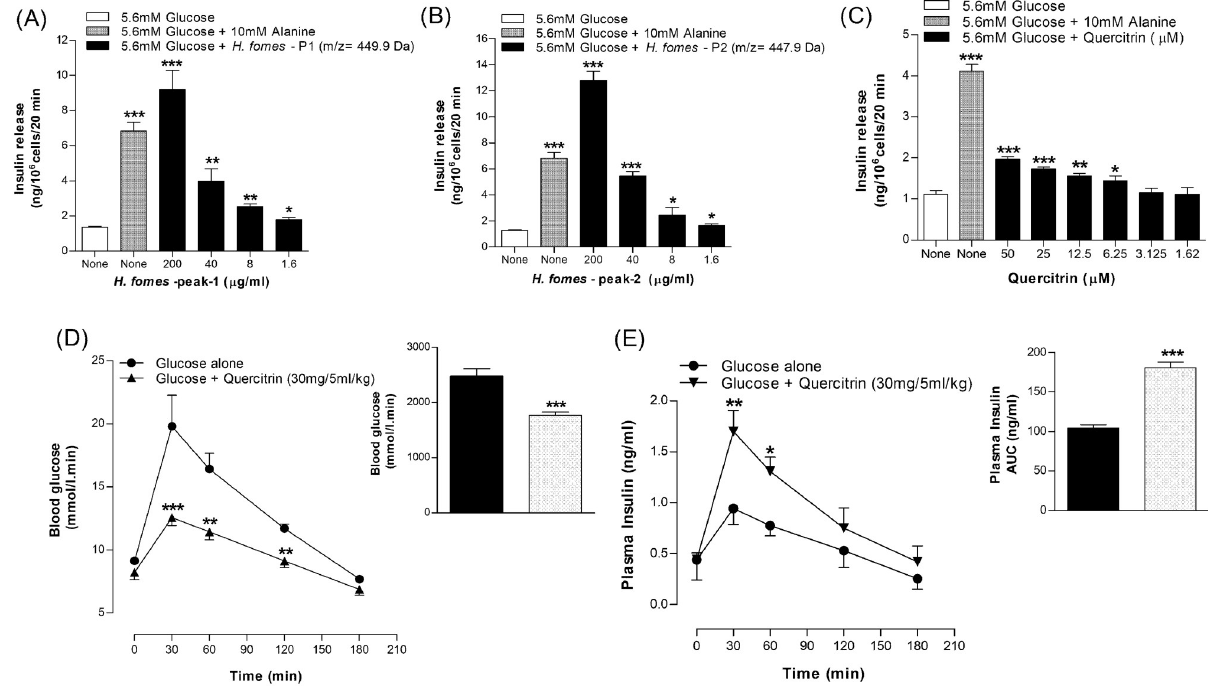
Fig 9. Insulin releasing effects of (A & B) Peak-1 & 2, (C) Quercitrin from BRIN-BD11 cells and, (D & E) glucose tolerance and plasma insulin in mice. Fasted (12 h) mice were administered glucose (18 mmol /5ml/kg, body weight) orally with or without (D & E) quercitrin (30 mg/5ml/kg b.w.). Values are Mean ± SEM for n = 8 for insulin release and n = 7 for glucose tolerance and plasma insulin. � p < 0.05, �� p < 0.01 and ��� p < 0.001 compared to control.